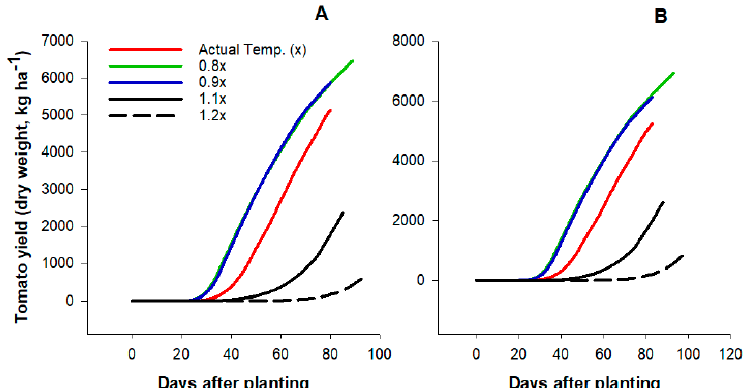
Figure 4. E ff ects of variations in air temperature on drip-irrigated fresh-market tomato yield of two Figure 4. Effects of variations in air temperature on drip ‐ irrigated fresh ‐ market tomato yield of two commercial varieties Charger ( A ) and Florida 47 ( B ) in Immokalee,